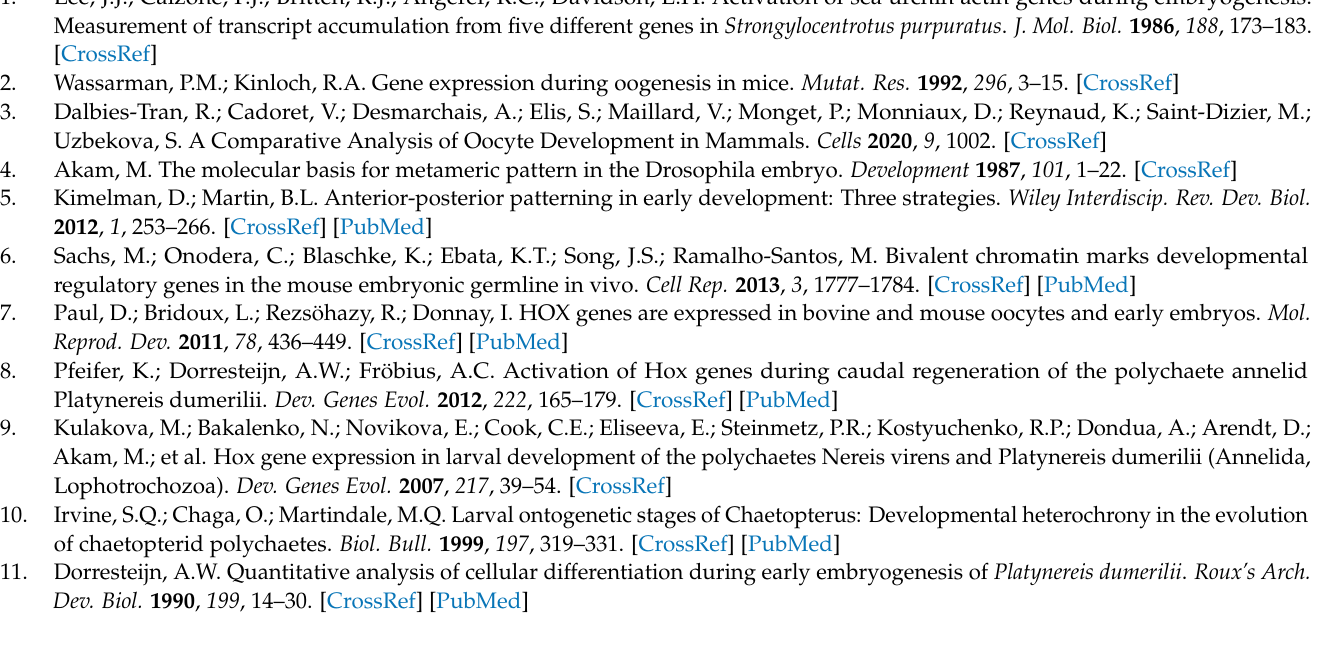
Figure S3: RT-PCR using intron-flanking primers, Figure S4: Results of check RT-PCR on cDNAs obtained from juvenile worm tails and oocytes, Figure S5: Strand-specific RT-PCR with two pairs of intron-flanking primers and sets of cDNAs obtained from juvenile worms and oocytes, Figure S6: Endogenous alkaline phosphatase inhibition control and Anti-Dig wash control, Figure S7: Results of in situ hybridization with antisense and sense Dig probes to Pdum-Acox3 , Figure S8: Example of a figure prepared to quantify the signal in the Fiji software, Table S1: List of primers used in this study, Table S2: Probes size for in situ, Table S3: Signal intensity values for all samples, Table S4: Signal intensity values after subtracting the antibodies’ background, Table S5: Signal intensity values after subtracting the Pdum-Acox3 sense probe background, Diagram S1: Diagram of the intensity of sense (s) and antisense (as) signals in situ after subtraction of the antibodies’ background, Diagram S2: Diagram of the intensity of sense (s) and antisense (as) signals in situ after subtracting of the Pdum- Acox3 sense probe background, List S1: Sequences of P. dumerilii Hox